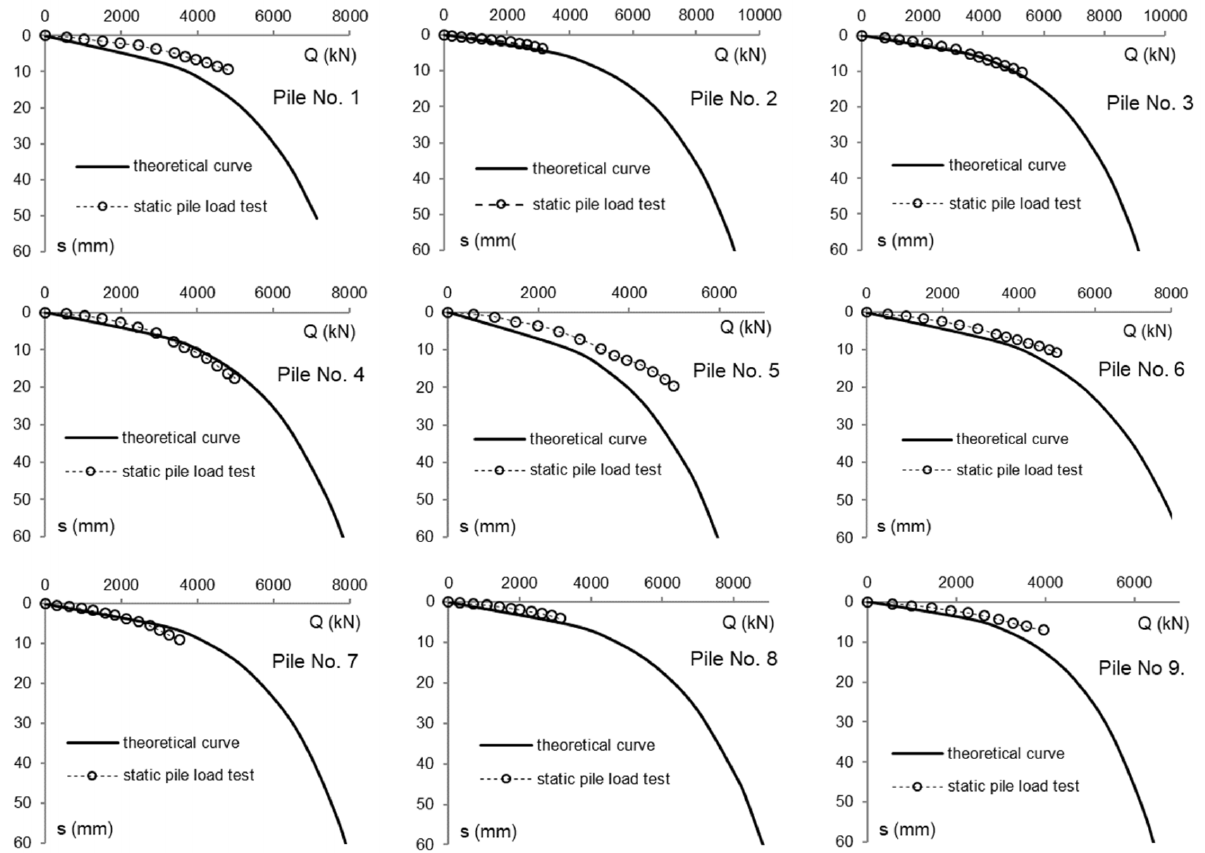
Figure 10: Comparison of theoretical curves with actual curves from static pile load tests.